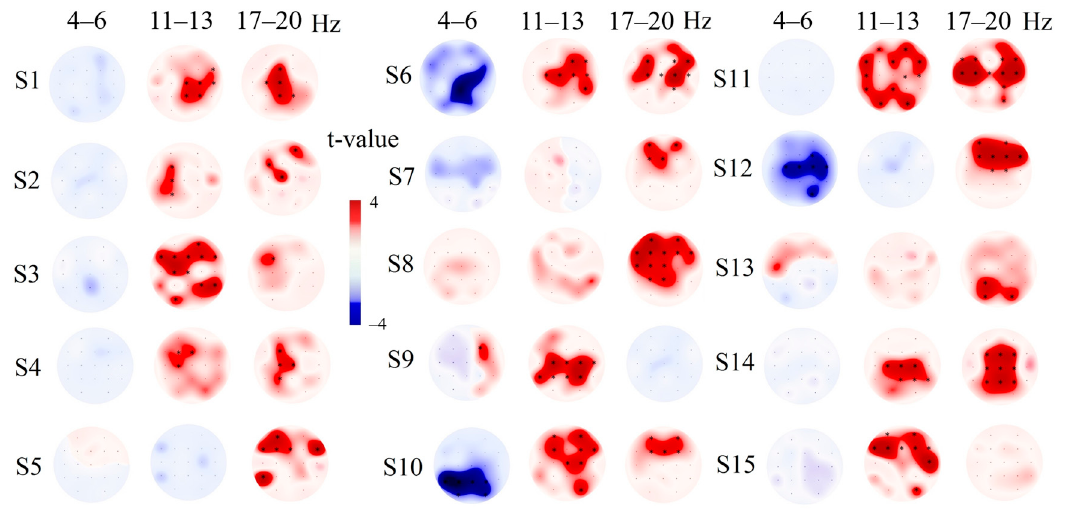
Figure 4. The individual di ff erences in theta rhythm (4–6 Hz), alpha rhythm 11–13 Hz, and beta rhythm PSD between tactile stimulation (4*10 trials) and the resting state. S1-15—subjects of the control group. The individual di ff erences between stimulus and rest were calculated using 4*10 trials of stimuli (each trial was 10 sec long) and 40 10-s resting-state intervals. The di ff erences were calculated for each participant separately ( p < 0.0026). The black stars indicate a significant di ff erence after Bonferroni correction .